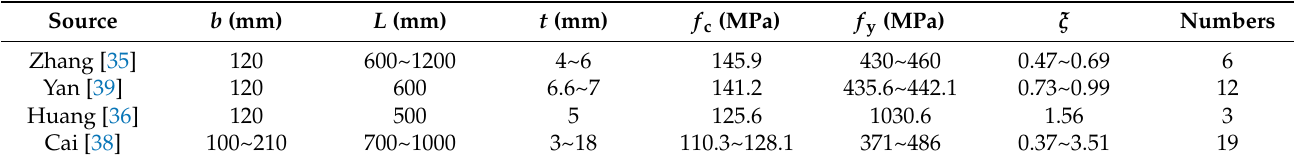
Table 3. Database of UHPCFSTs subjected to combined axial compression and bending.